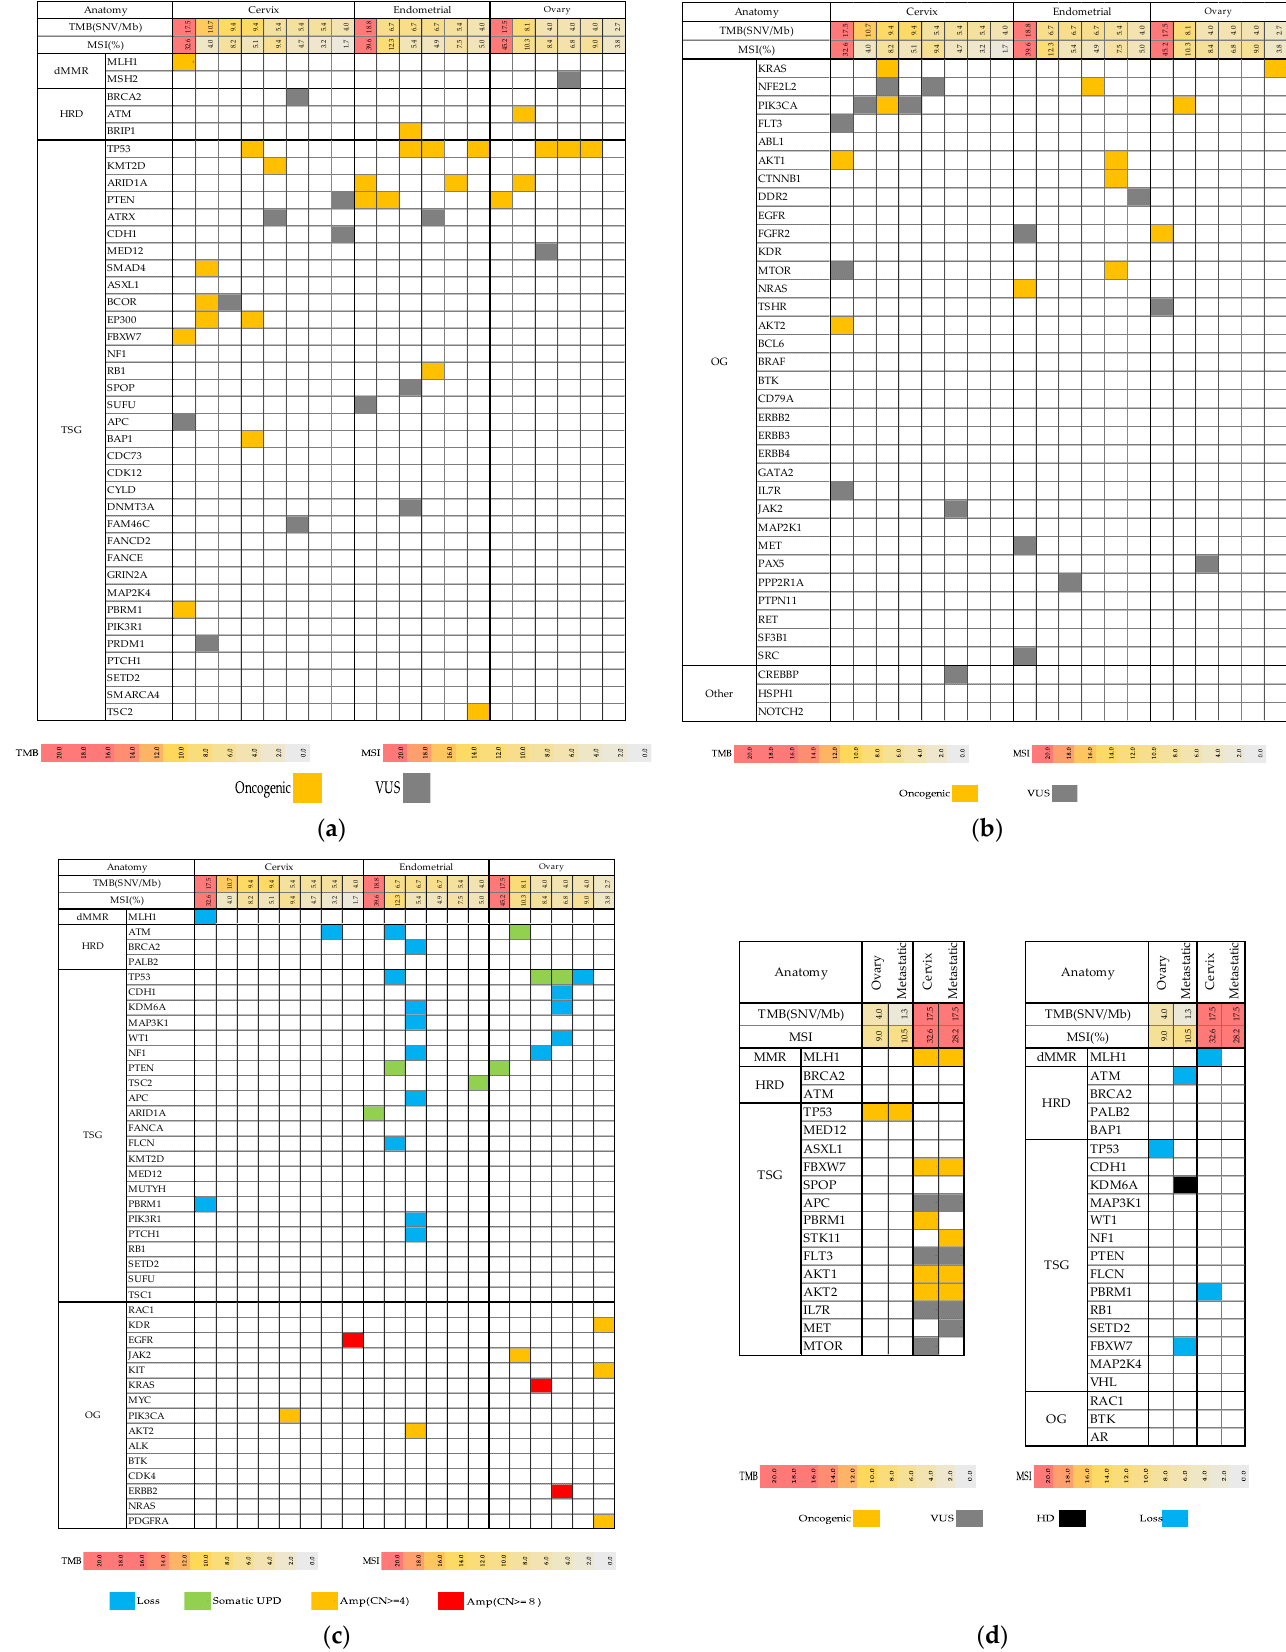
Figure 1. Distribution of molecular alterations identified by 160-gene panel investigation. ( a ). Genes related to dMMR, HRD, and TSG alterations. Orange is an oncogenic alteration and gray is VUS. ( b ) . There are OG alterations and others identified by 160-gene panel investigations. Orange is an oncogenic alteration and gray is VUS. ( c ) . There are various types of molecular alterations: blue, loss; green, somatic UPD; orange, amp (CN > 4); and red, amp (CN > 8). ( d ) . Comparison of gene mutations in primary and metastatic lesions in ovarian and cervical cancers.TMB: tumor mutation burden, MSI: microsatellite instability, dMMR: deficient mismatch repair, HRD: homologous recombination deficiency, TSG: tumor suppressor gene, VUS: variants of unknown significance, OG: oncogene, UPD: uniparental disomy, Amp: amplification. 2.3. Genotype-Matched Therapy Genotype-matched therapy was performed in seven cases (35%). Among them, there was one case of cervical cancer, five cases of endometrial cancer, and one case of ovarian cancer. Pembrolizumab was used in two patients (based on MSI-high status): one patient had progressive disease (PD), and the other had an unknown outcome for transfer to an- other hospital. Olaparib was used in one patient (based on HRD) who showed a CR on a computed tomography (CT) scan, which was performed after 2 months. However, 9 months later, recurrence was observed. Four patients were treated with everolimus (based on PTEN, TSC2, mTOR, CTNNB1, and NF1 status): in one case (based on PTEN status), only everolimus was used, whereas in the rest of the cases it was combined with letrozole. The patients with EC who only used everolimus were positive for the neuron specific enolase (NSE) marker in immunohistochemistry. In Japan, in most cases, the cost of gen- otype-matched therapy is not covered by insurance. If the patients are positive for the NSE marker, insurance can be used to cover their expenses. For this reason, letrozole was not used. One study found that a combination of everolimus and letrozole was associated with extend PFS in cases of ER-positive high-grade ovarian cancer in a phase Ⅱ study [6]. Therefore, in our study, a combination of everolimus and letrozole was used in cases of ovarian cancer if the patient was positive for ER. One case (based on PTEN status) showed SD, one case (based on TSC2 status) showed PR, and two cases had PD (Table 2).